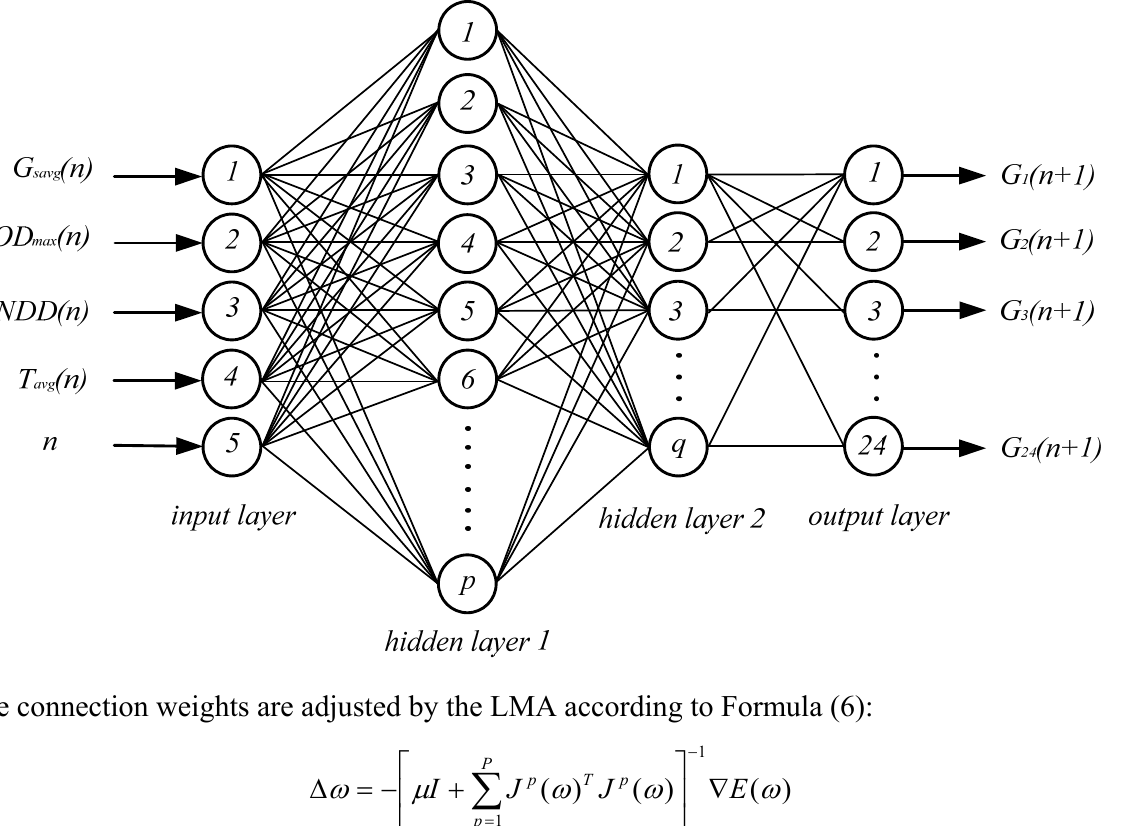
Figure 4. ANN forecast model using statistical feature